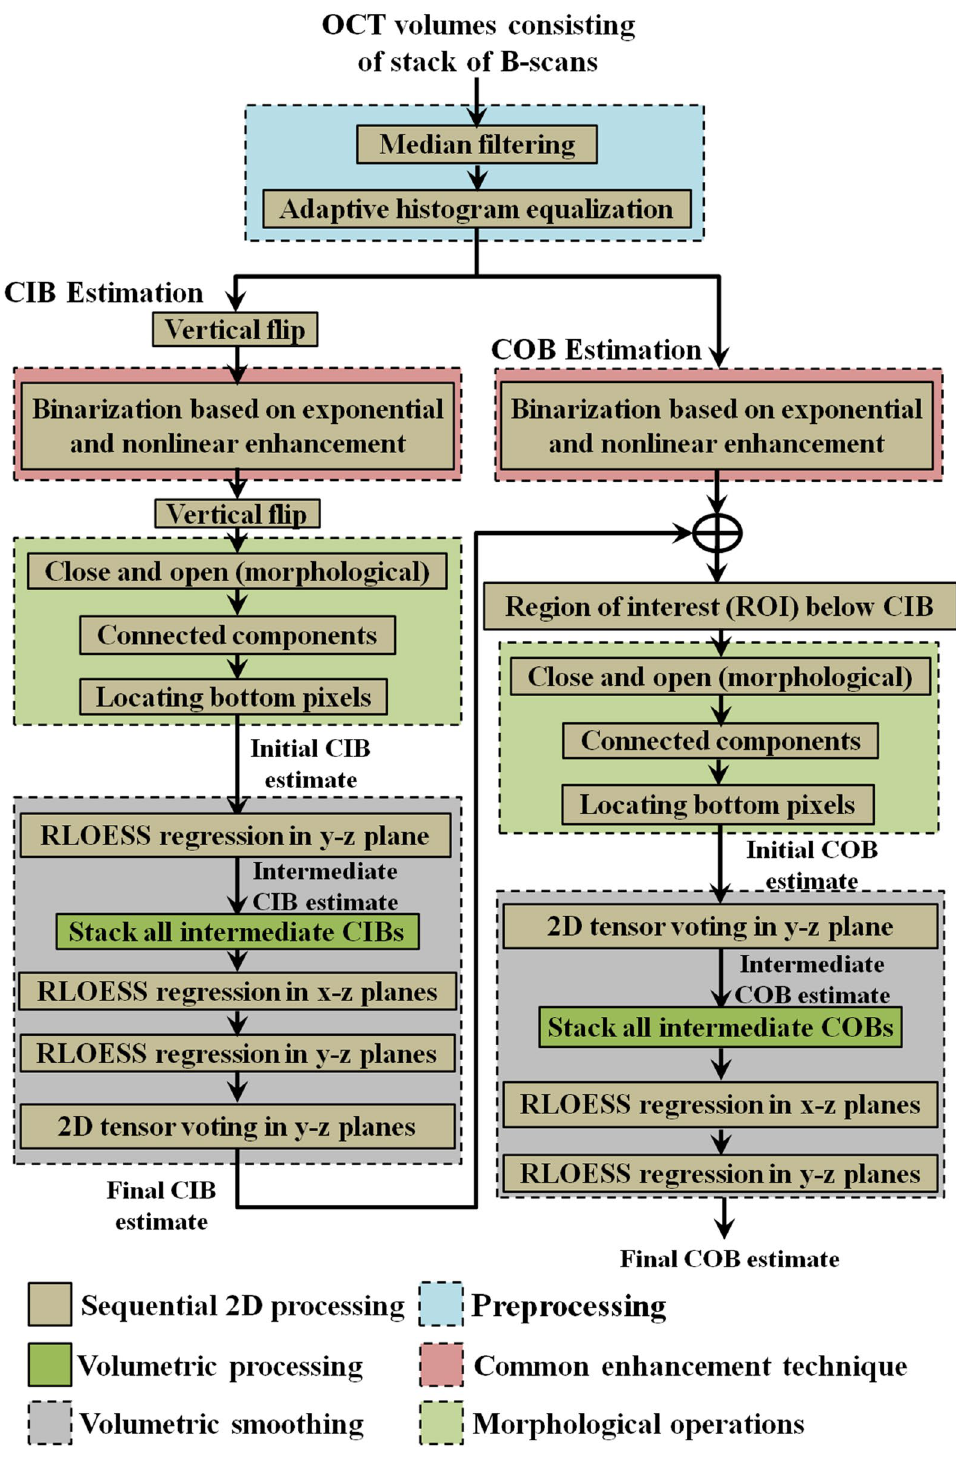
Figure 3. Schematic algorithm to demarcate the inner and outer choroidal boundaries ( CIB choroidal inner boundary, COB choroidal outer